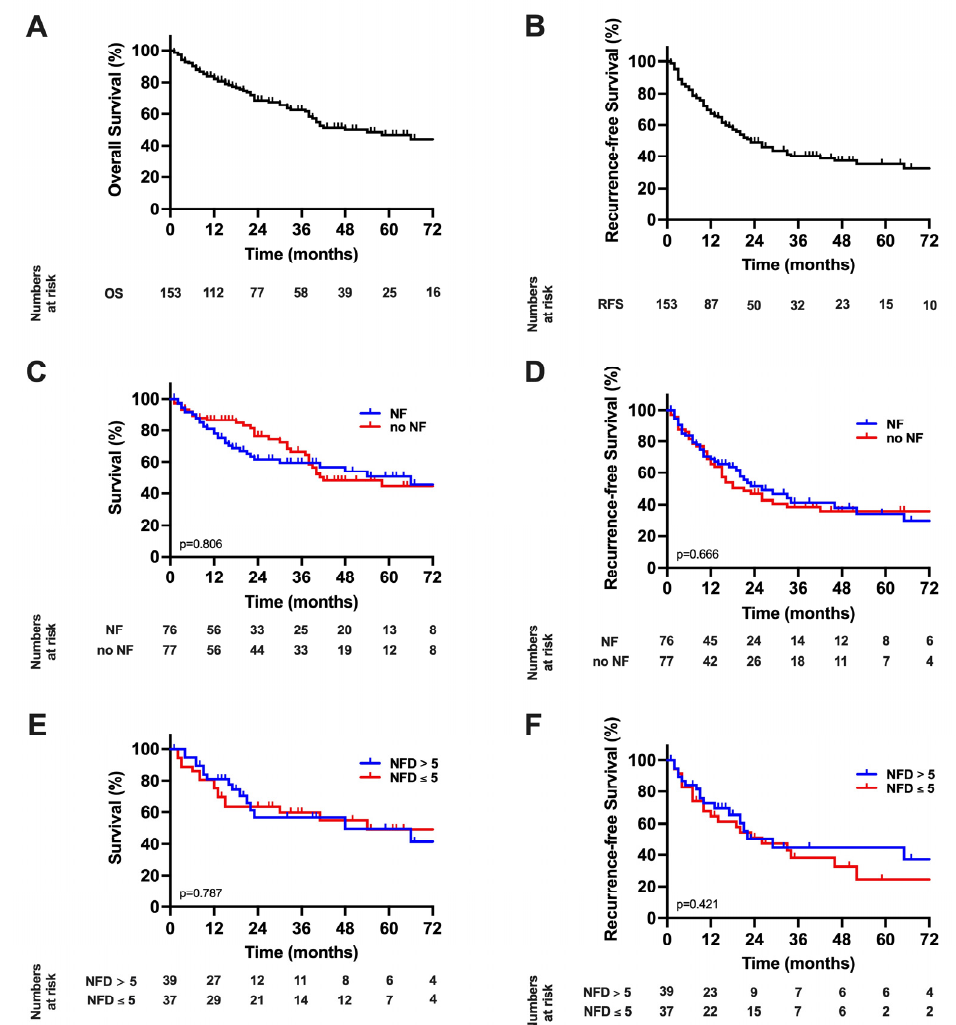
Figure 2. Long-term outcome in hepatocellular carcinoma; ( A ) Overall survival. The median OS of the study cohort was 54 months; ( B ) Recurrence-free survival. The median RFS was 23 months; ( C ) Overall survival stratified by nerve fibers. The median OS of 66 months in patients with NF compared to 42 months ( p = 0.804 log-rank). ( D ) Recurrence-free survival stratified by nerve fibers. The median RFS was 26 months in patients with NF compared to 18 months in patients without NF ( p = 0.666 log-rank). ( E ) Overall survival in patients with nerve fibers survival stratified by nerve fiber density. The median OS was 54 months in patients with NFD ≤ 5 compared to 48 months in patients with NFD > 5 ( p = 0.787 log-rank). ( F ) Recurrence-free survival in patients with nerve fibers survival stratified by nerve fiber density. The RFS was 26 months in patients with NFD ≤ 5 and 29 months patients with NFD > 5 ( p = 0.421 log-rank). RFS, recurrence-free survival; OS, overall